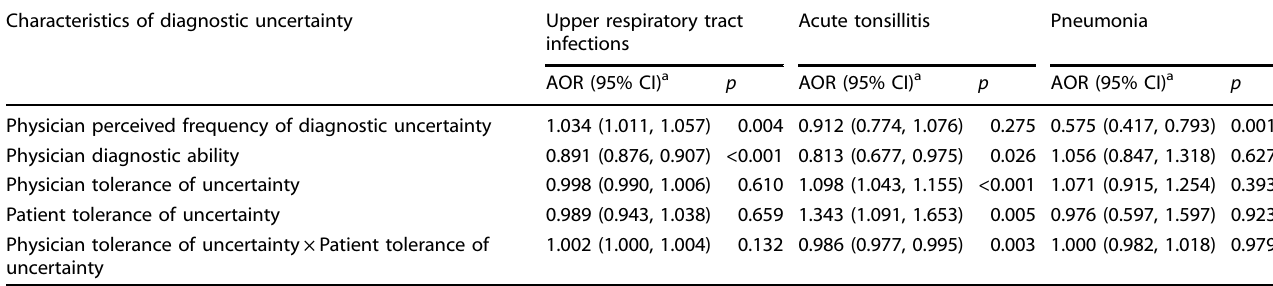
Table 2. Effects of diagnostic uncertainty on antibiotic-prescribing behaviours in primary care physicians.